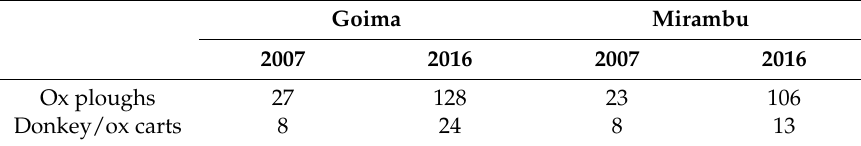
Note: Ploughs and carts were not counted in the first survey.